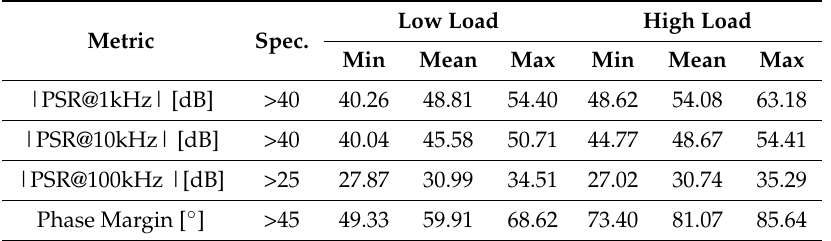
Table 5. Performance metrics of the Pareto front solutions obtained through SQP optimization of the CL-LDO in a 130 nm process measured with